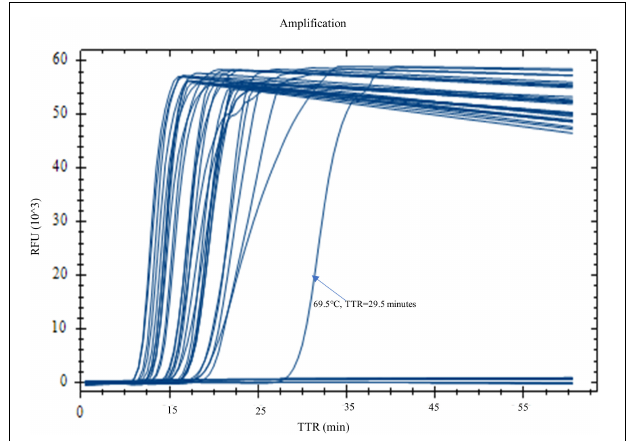
FIGURE 1 | Optimization of reaction temperature by real-time LAMP. LAMP reactions with Yersinia pestis DNA (1 pg) were carried out on a real-time PCR instrument at a temperature gradient of 60–70 ◦ C (60, 60.7, 62, 64, 66.4, 68.4, 69.5, and 70 ◦ C). Four replicates were tested for each temperature. Four out of four replicates were amplified at all temperatures, except for 70 ◦ C. Temperatures 66.4 and 64 ◦ C generated the best results with shorter TTR and a more even amplification